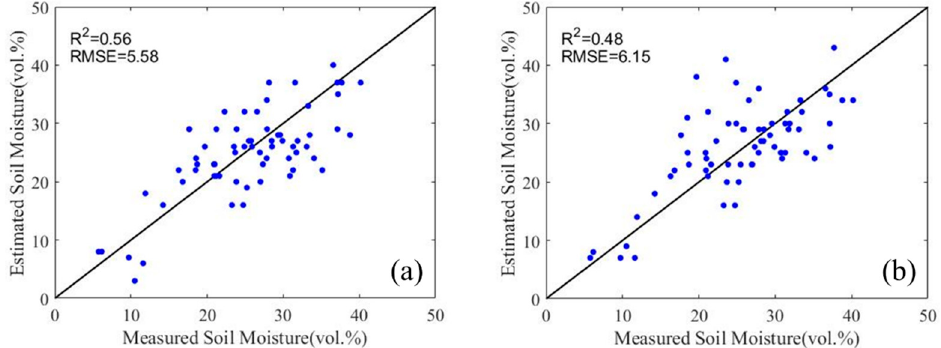
Figure 6. Scatterplots between the measured and predicted SMC values on the validation set based on RVI (Ratio method).